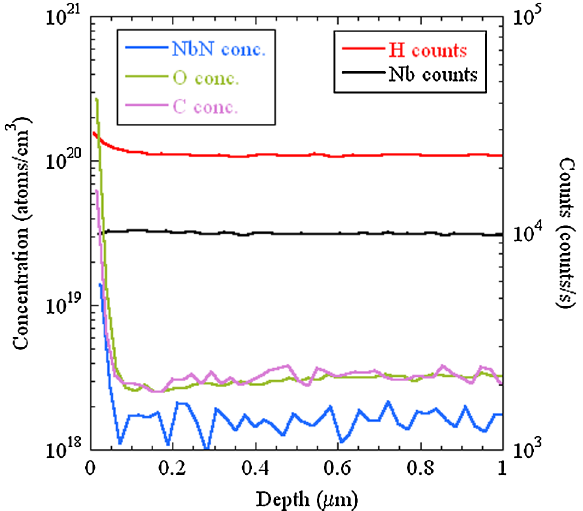
FIG. 25. (Color) SIMS reduced data depth profile for the fine- grain heat treated sample F3. The heat-treatment parameters are 800 (cid:1) C 3 h = 400 (cid:1) C 20 min (see Table